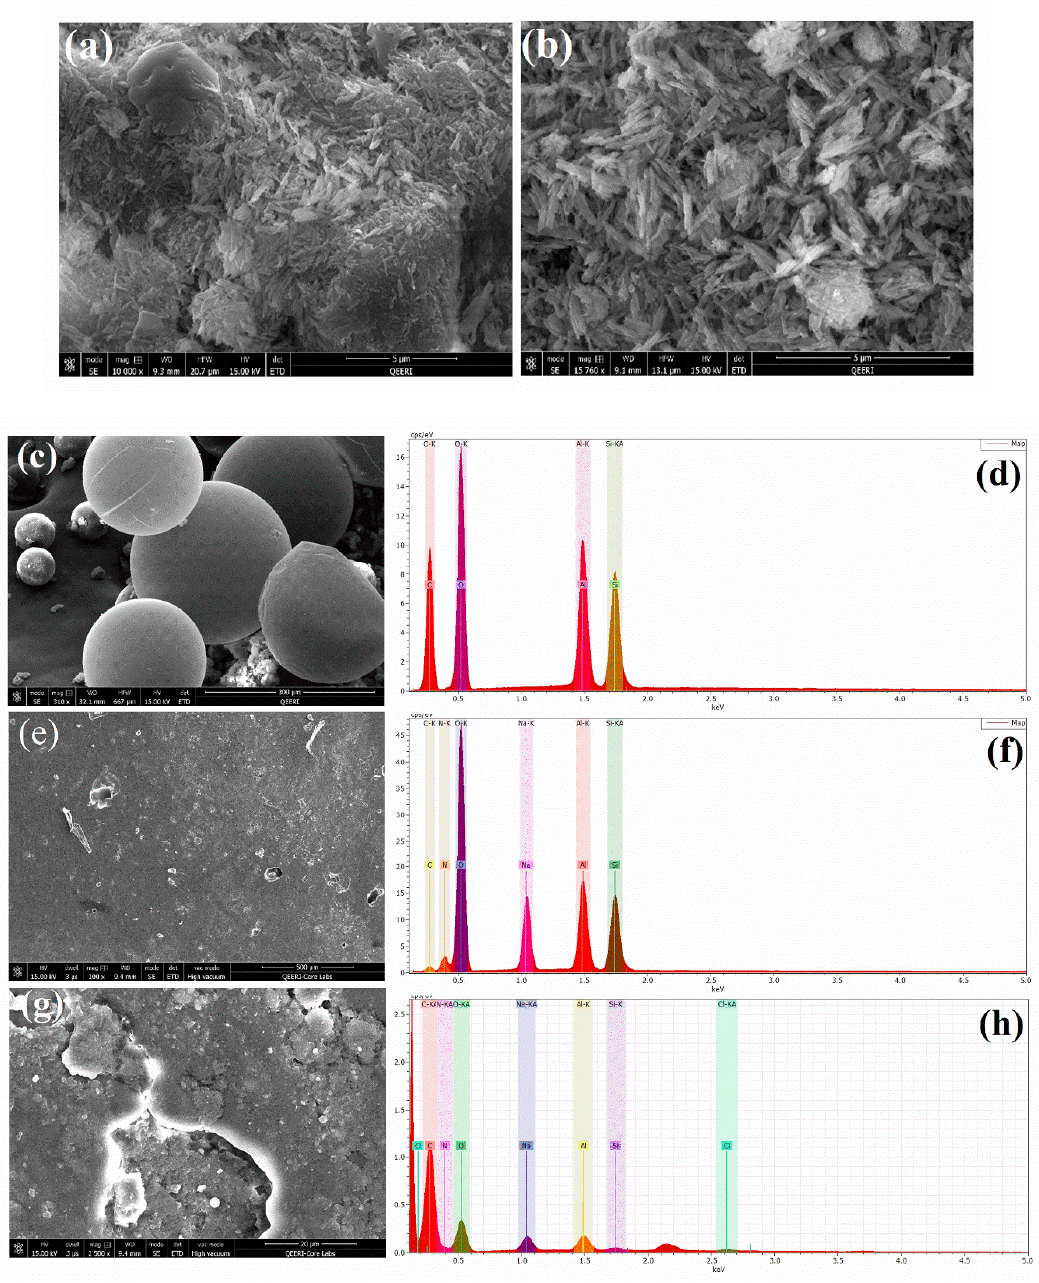
Figure 3. Field emission scanning electron microscope (FE–SEM) analysis of: ( a ) halloysite